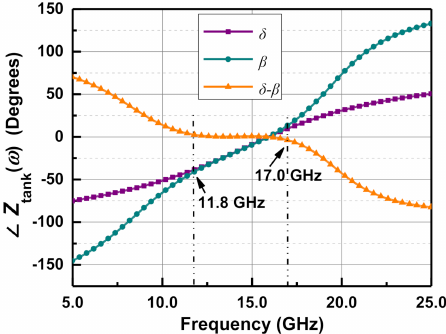
Figure 3. AC equivalent circuit of the tank. ( a ) Taking R p into consideration. ( b ) Taking R p and R s into consideration.